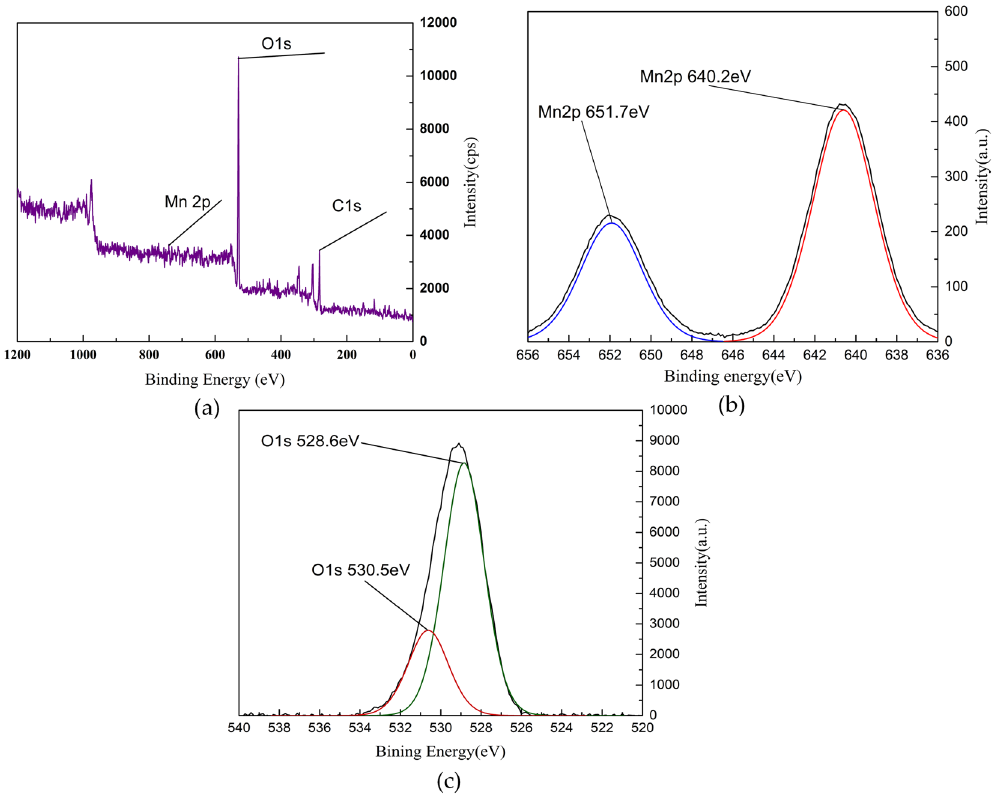
Figure 9. XPS spectrogram of MnOx-based sludge (not involved in the denitration reaction). ( a ) Full scan spectra of MnOx; ( b ) Mn 2 P spectra of MnOx; ( c ) O 1 s spectra of